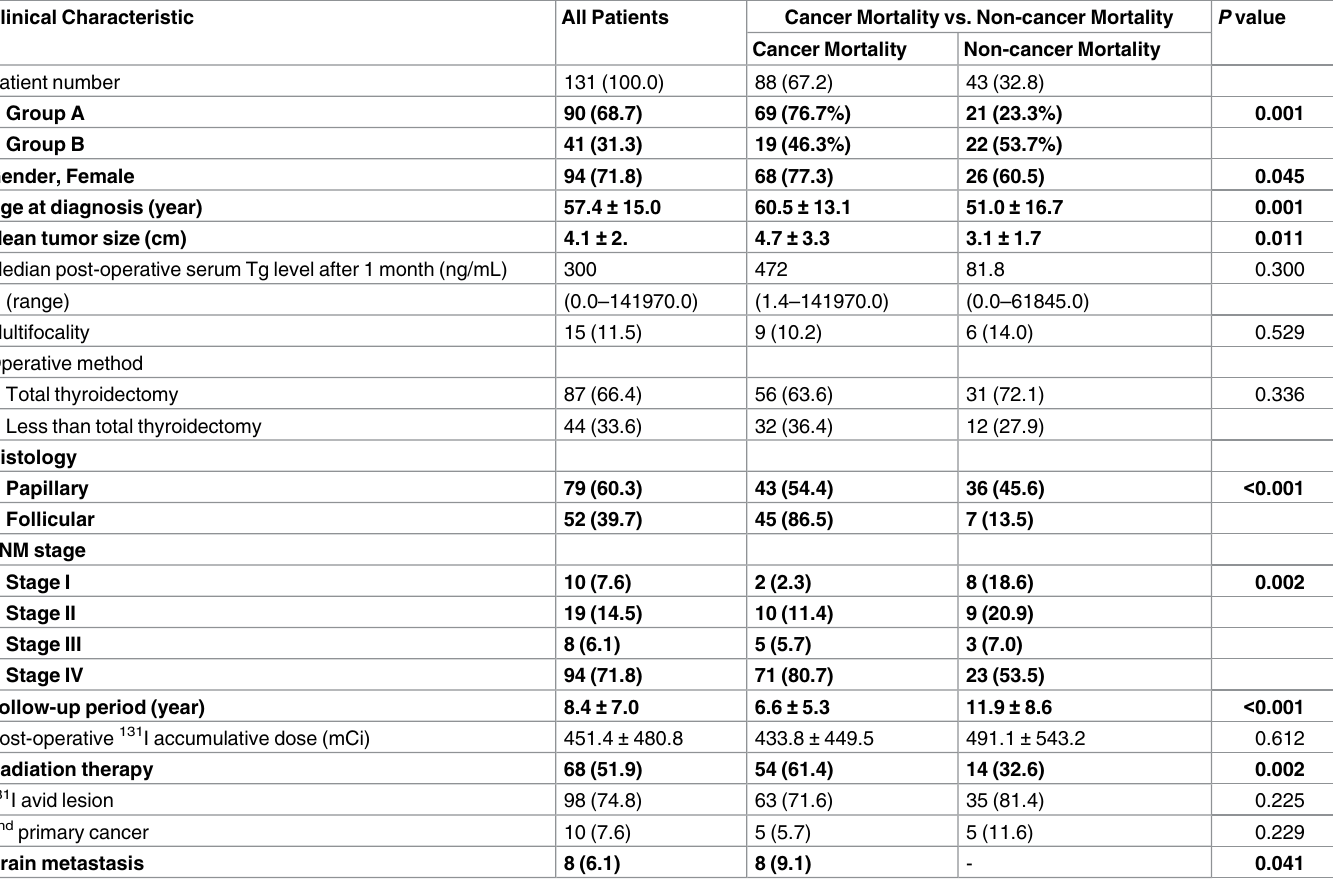
Table 2. Clinical featuresof papillary or follicular thyroid cancer with bone metastasis in thyroid cancer mortality or non-cancer